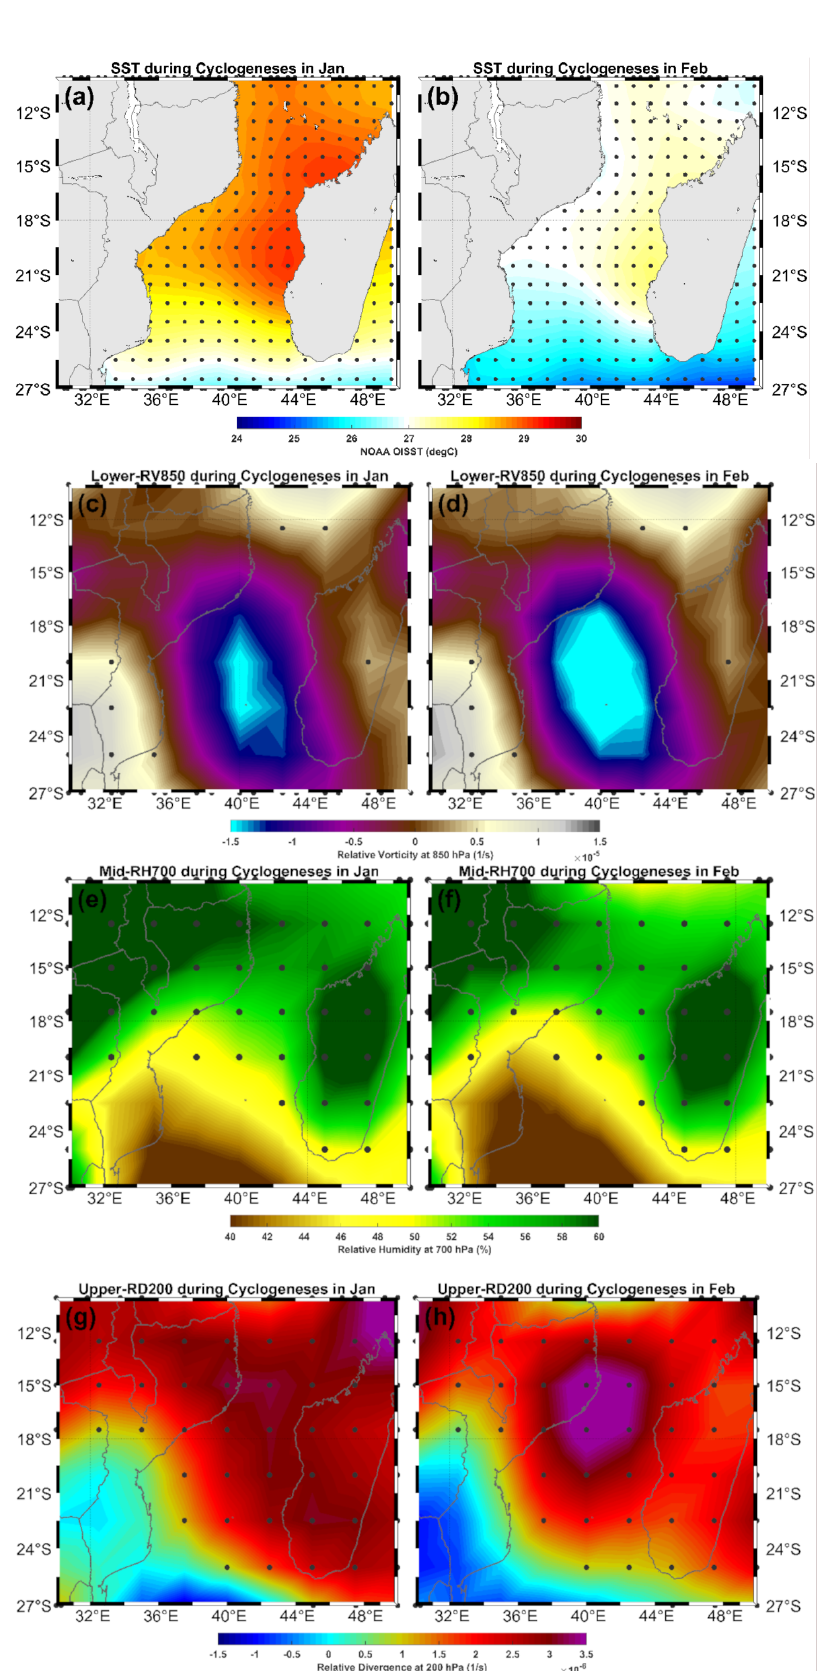
Figure 10. Composite mean of SST ( a , b ), vorticity at 850 hPa ( c , d ), relative humidity at 700 hPa ( e , f ) and divergence at 200 hPa ( g , h ) for January (left panel) and February (right panel) cyclogenesis (dots indicate 95% t -test confidence